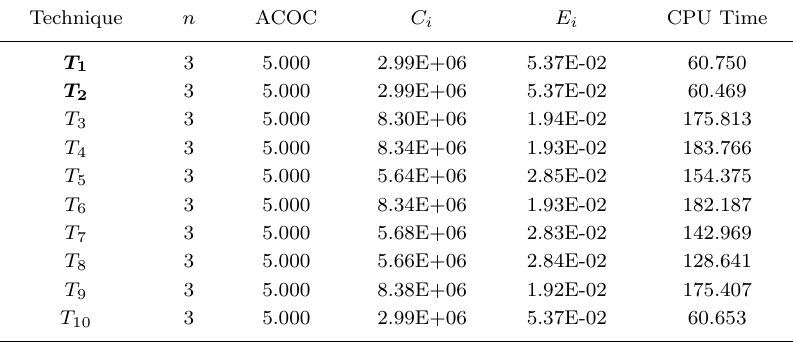
Table 5. Comparison of performance of techniques for Problem